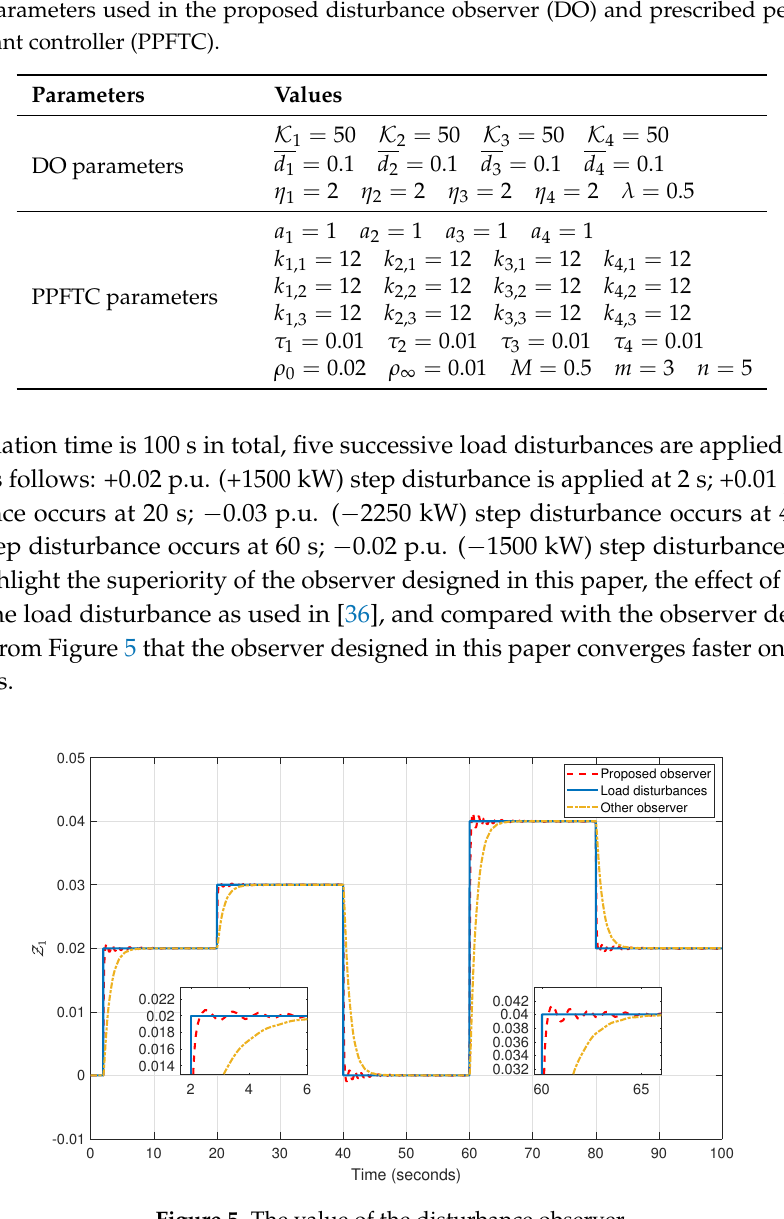
Figure 5. The value of the disturbance